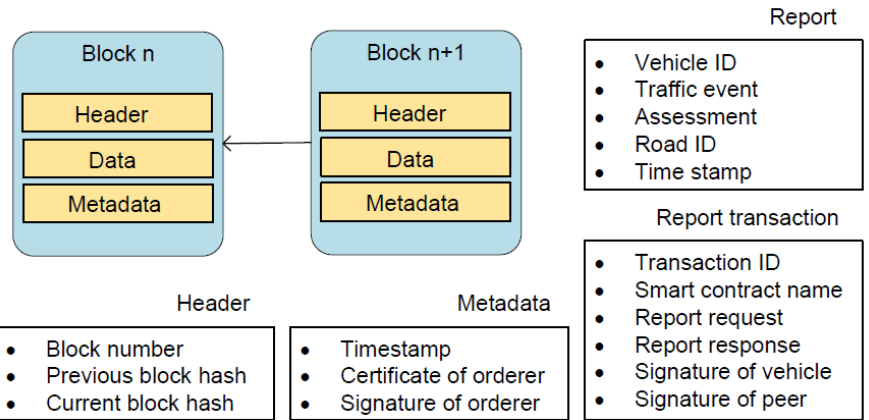
Figure 6. Data structures involved in